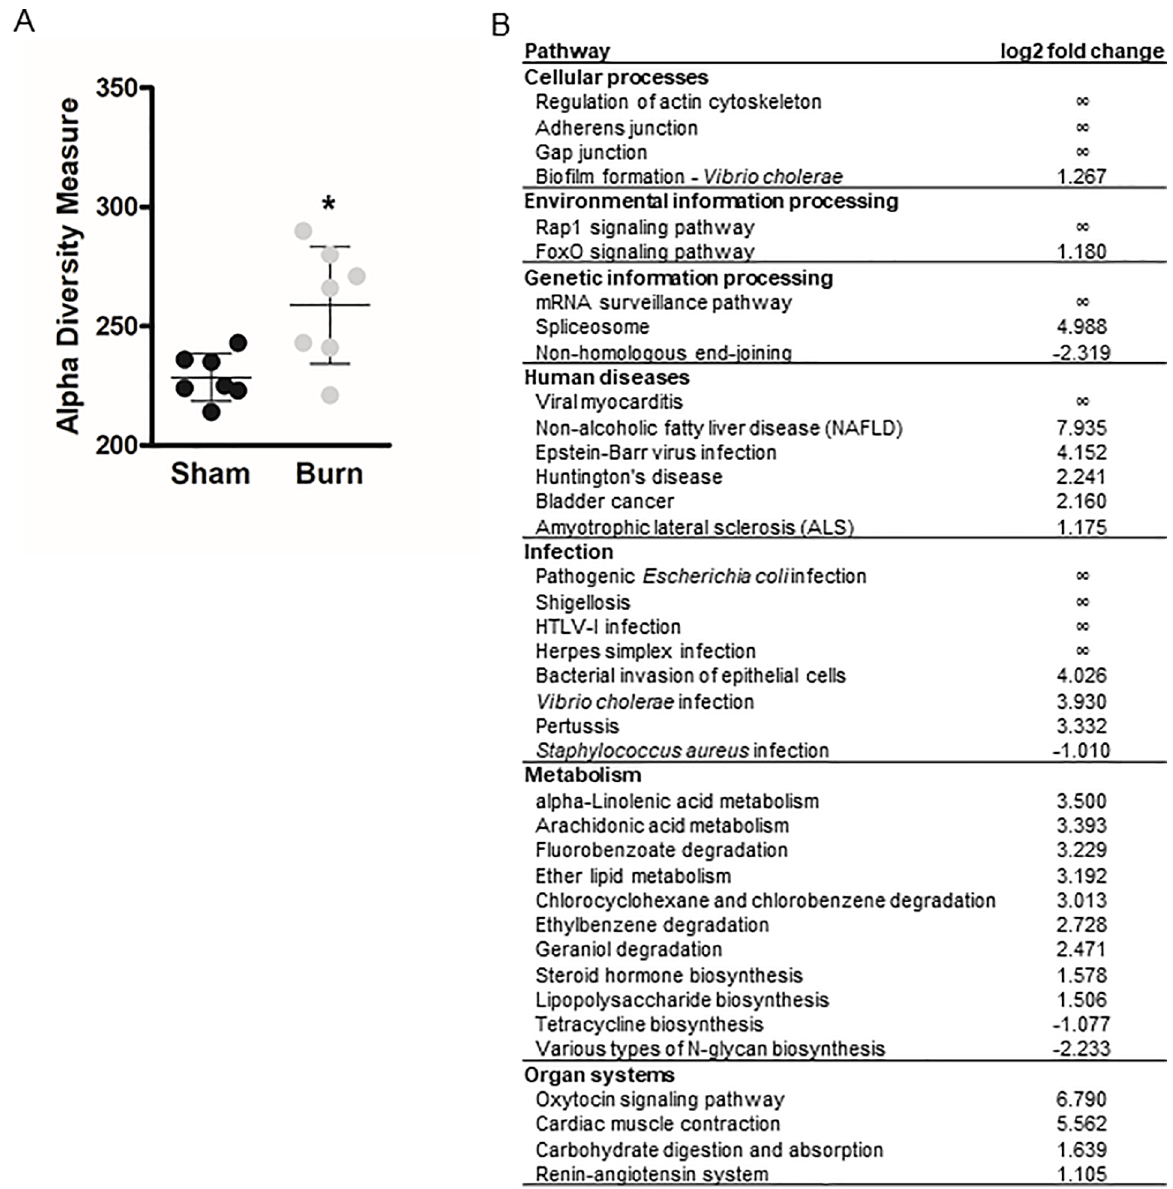
Fig 4. Pathway diversity is altered upon burn injury. The degree of variation of signaling pathways within a sample was assessed after burn or sham injury ( A ). Each replicate is presented, as well as mean ± SD. Asterisks indicate significant differences as assessed by Kruskal-Wallis rank sum test. Differentially abundant pathways in the cecal microbiome ( B ) were considered significant if their FDR-corrected p-value was less than or equal to 0.05 and the absolute value of the log-2 fold change was greater than or equal to 1. Infinite log-2 fold changes indicate that the other groups mean abundance is 0. Out of the 331 pathways tested, only the 38 pathways, whose abundance was significantly altered, are